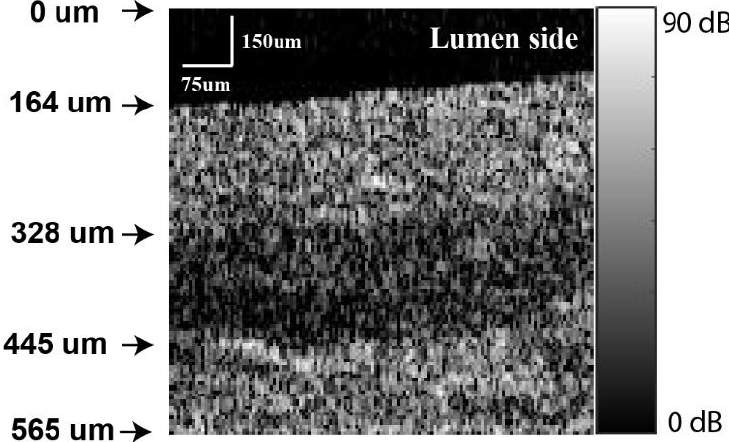
Figure 5. An example of layer thickness measurement of oesophageal tissue layer.